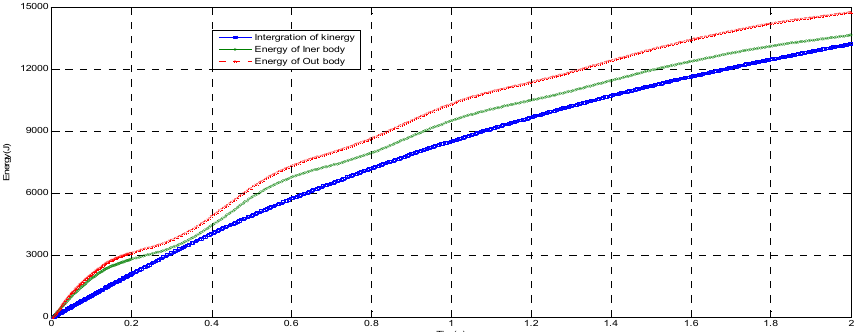
Figure 17. The plot of energy vs. time and the integration of shell part energy.